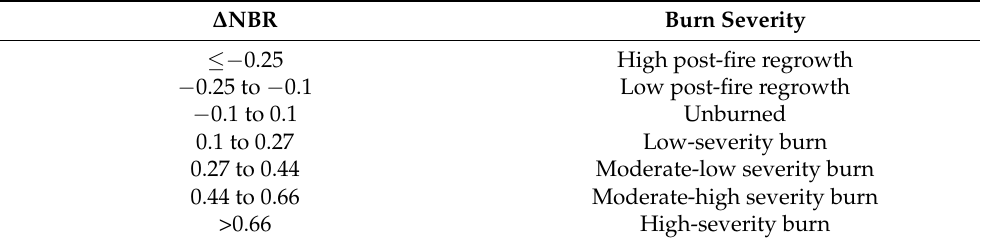
Table 1. The ∆ NBR burn severity categories, according to the United States Geological Survey (USGS) categorization. ∆ NBR ≤−